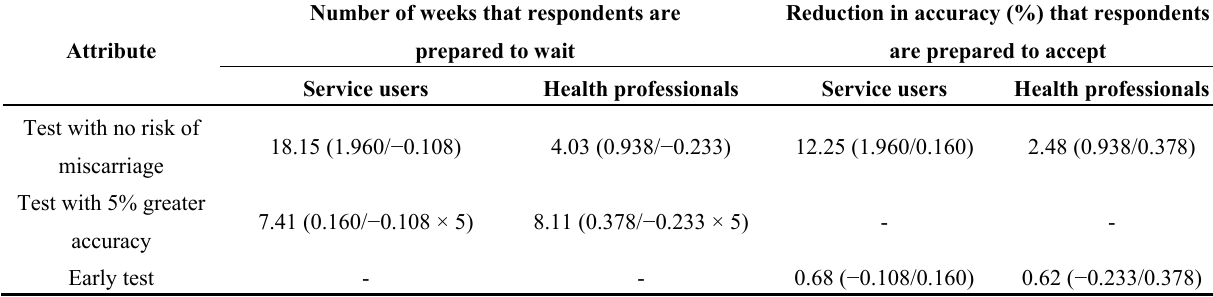
Table 3. Marginal rates of